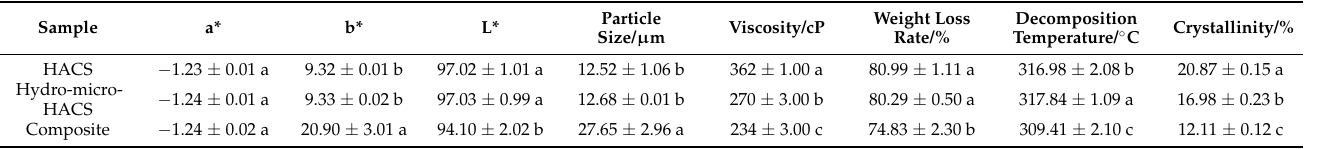
Table 1. Color, particle sizes, viscosity, thermal gravimetric analyzer (TGA) characteristics, and crystallinity of the HACS, hydro-micro-HACS, and